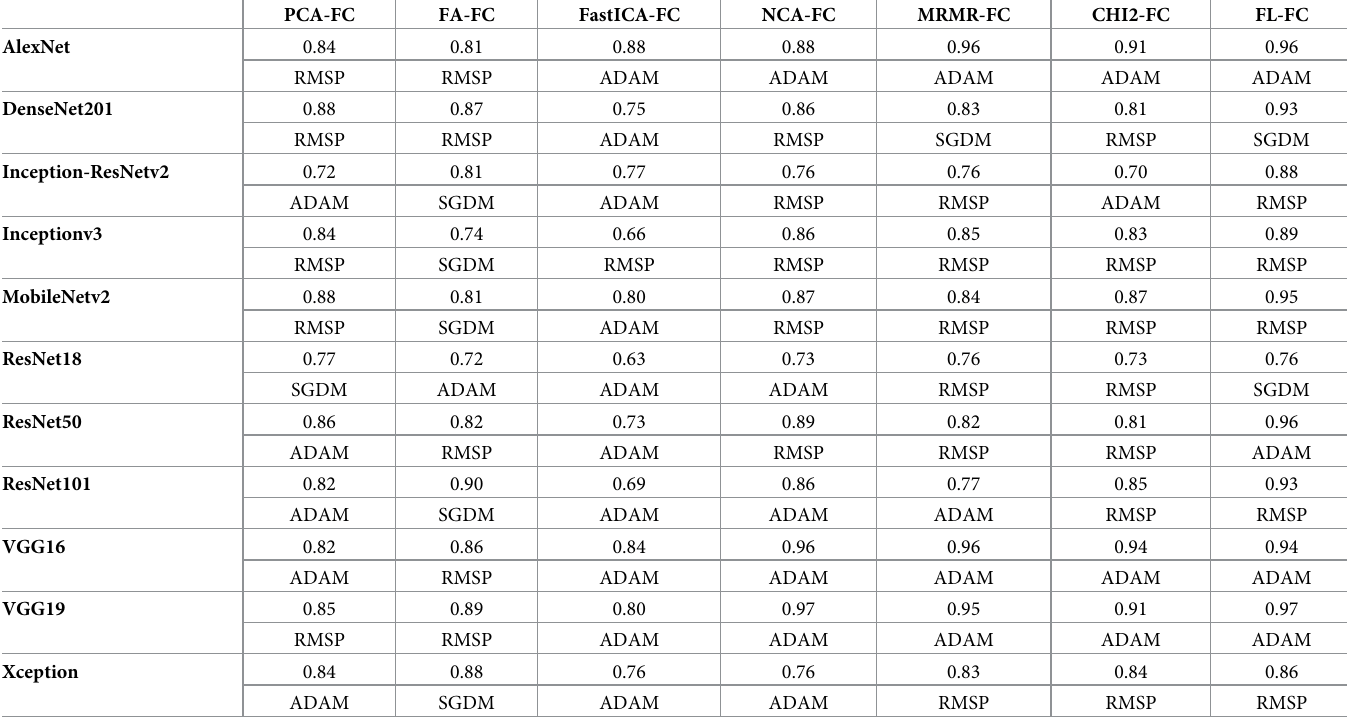
Table 14. The best FC learning optimizer for each combination method and its average classification performance (using F1-Score metric). PCA-FC FA-FC